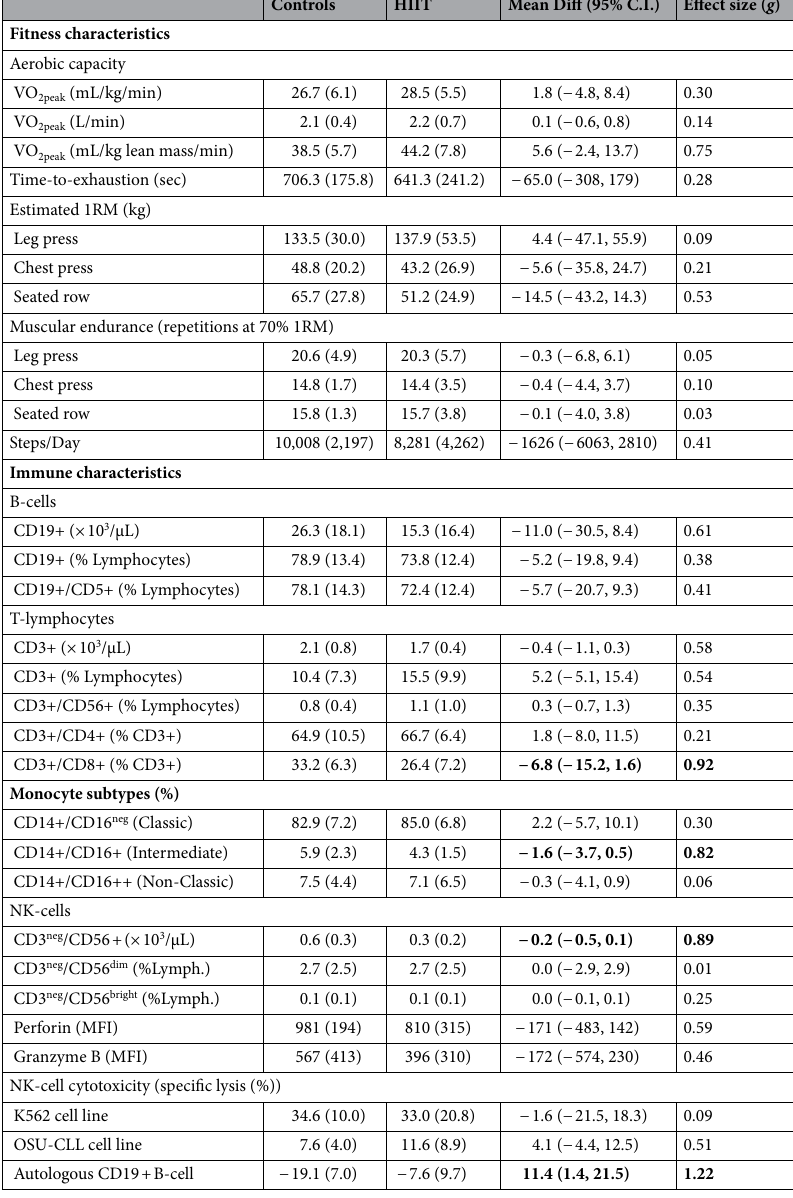
Table 3. Baseline fitness and immune characteristics of participants completing the intervention. Data are mean (SD) or mean difference (95% C.I.), unless otherwise indicated. Bolded effect sizes indicate large effect sizes for mean differences between